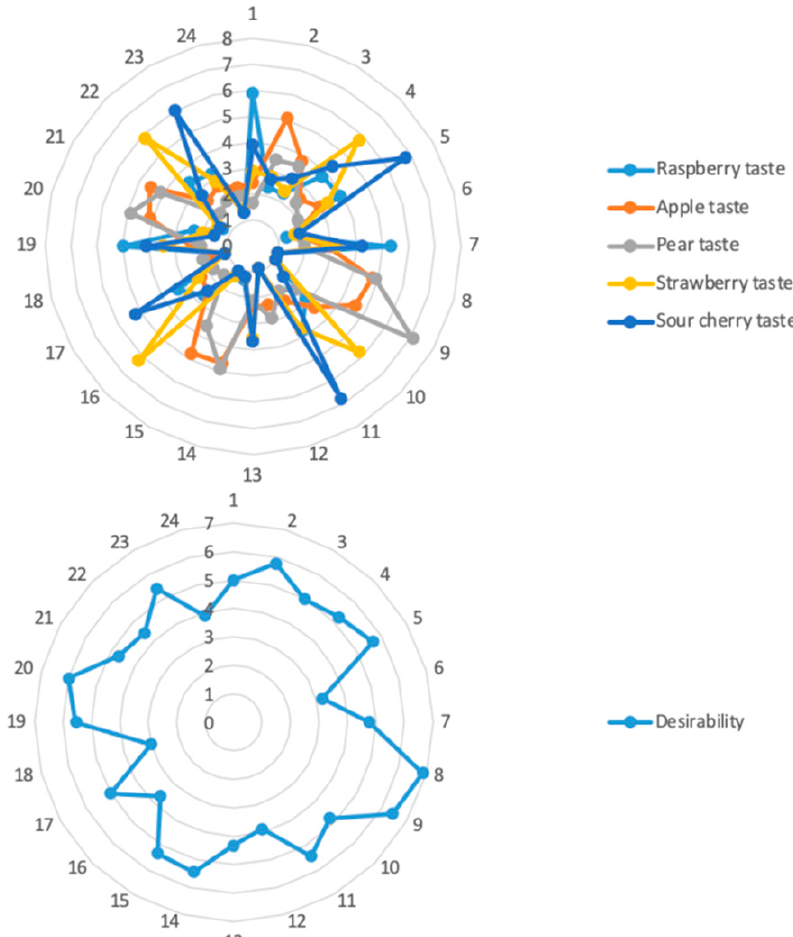
Figure 4. Sensorial characteristics of carrot blended smoothies according to the flavor of the final product and sensorial preferences (1, RJ–PC; 2, AJ–PC; 3, PJ–PC; 4, SJ–PC; 5, SCJ–PC; 6, PC%100; 7,